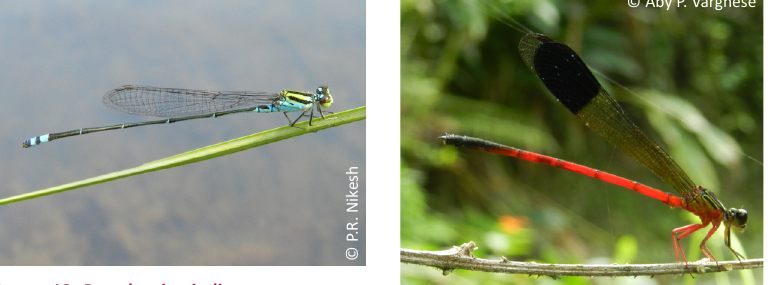
e t h M a o i j © J